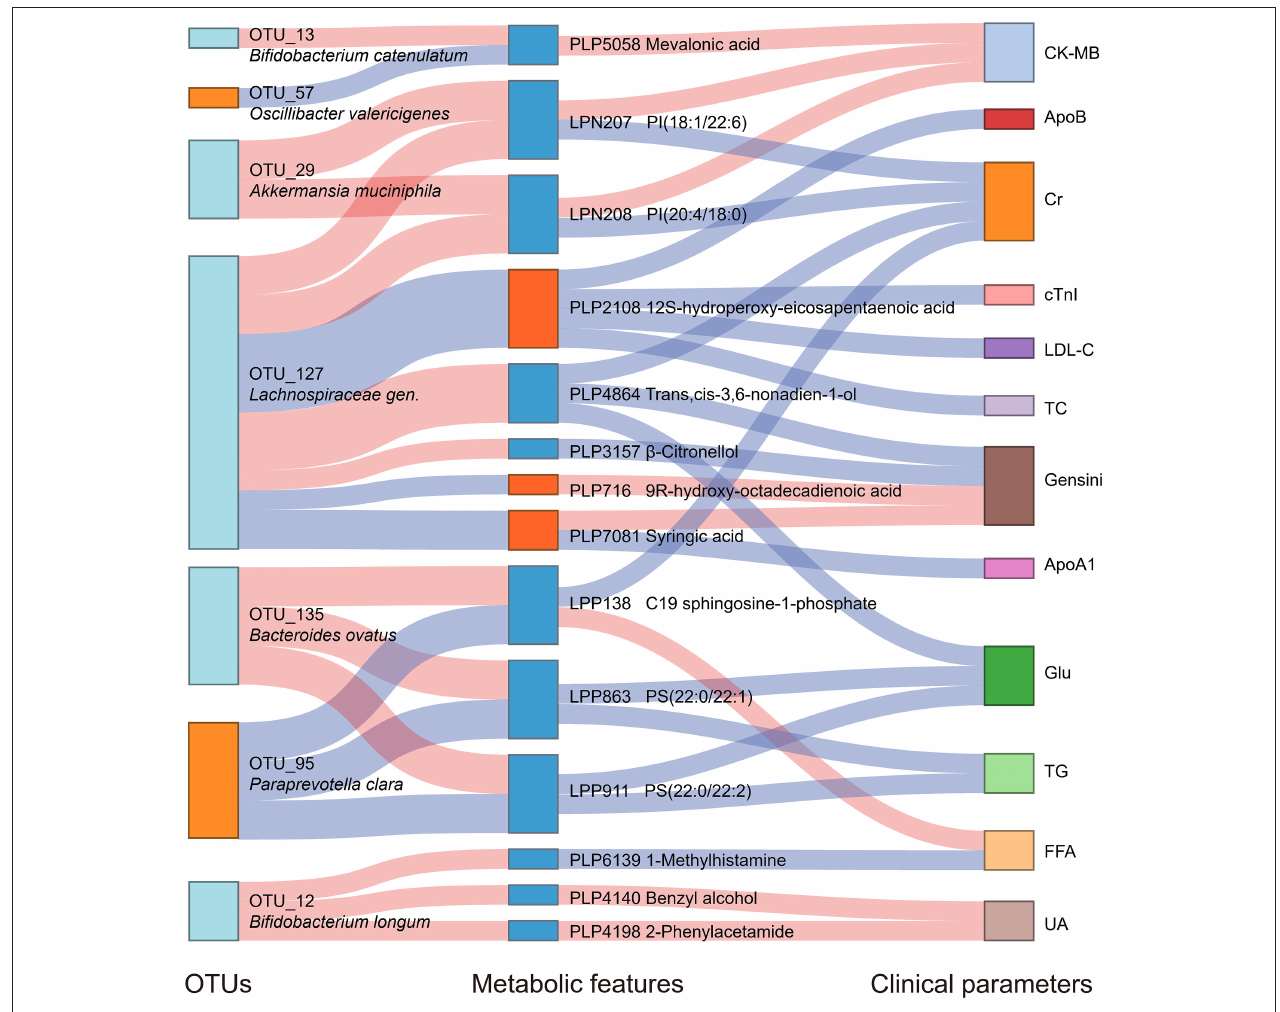
FIGURE 6 | Interrelationship between intestinal flora, serum metabolic features, and major clinical parameters associated with moderate alcohol consumption with CAD. A Sankey plot was utilized to examine the relationship among the differential OTUs and serum metabolites associated with moderate alcohol consumption, and major clinical parameters of CAD. Red connections indicate significant positive correlations, and blue connections indicate significant negative correlations (Spearman correlation analysis, P < 0.05). In the left column, light blue boxes indicate OTUs that are significantly depleted in MD-CAD when compared with ND-CAD and HD-CAD, and light orange boxes indicate OTUs that are significantly elevated in MD-CAD when compared with ND-CAD and HD-CAD. In the middle column, dark blue boxes indicate metabolic features that are significantly decreased in MD-CAD when compared with ND-CAD and HD-CAD, and dark orange boxes indicate metabolic features that are significantly increased in MD-CAD when compared with ND-CAD and HD-CAD. The right column exhibits some major clinical parameters of CAD. CK-MB, creatine kinase-MB; cTnI, cardiac tropinin I; Cr, creatine; ApoA1, apolipoprotein A1; Glu, fasting blood glucose; TG, triglyceride; FFA, free fatty acid; UA, uric acid; ApoB, apolipoprotein B; LDL-C, low-density lipoprotein cholesterol; TC, total